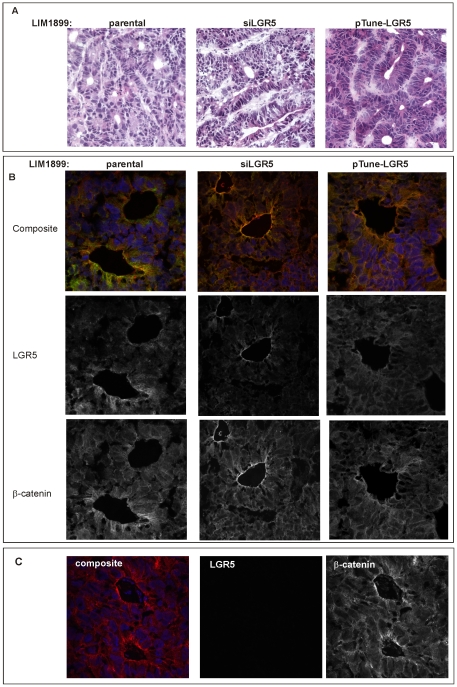
Morphology and LGR5 reactivity of xenografts tumours.A) Haematoxilin and eosin staining of frozen sections from representative tumours generated from parental LIM1899, LIM1899 transfected with siRNA to LGR5 or LIM1899 transfected with pTune-LGR5 construct. Brightfield images were acquired on a Nikon 90i microscope with a 20× lens. B) Confocal images of frozen sections stained with antibodies to β-catenin (red), LGR5 (green) or the DNA stain DAPI (blue). All images are Z-stacks of confocal sections. For each set, the upper panel shows the three combined stains, the middle panel LGR5 (greyscale), and the bottom panel β-catenin (greyscale). Images were obtained on a Nikon C1 confocal microscope with a 60× oil lens. C) Specificity control for LGR5 staining: frozen sections were stained with antibody to β-catenin and normal rabbit serum, followed by Alexa 488 anti-rabbit Ig (green) and Alexa 546 anti-mouse Ig (red) and the nuclear stain DAPI (blue). The green channel (NRS) and red channel (β-catenin) are shown separately in greyscale. Images were obtained as in B).